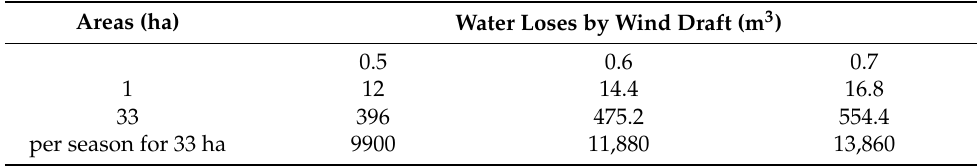
Table 2. Irrigation water lost by wind draft during an irrigation event from the center pivot irriga- tion method.